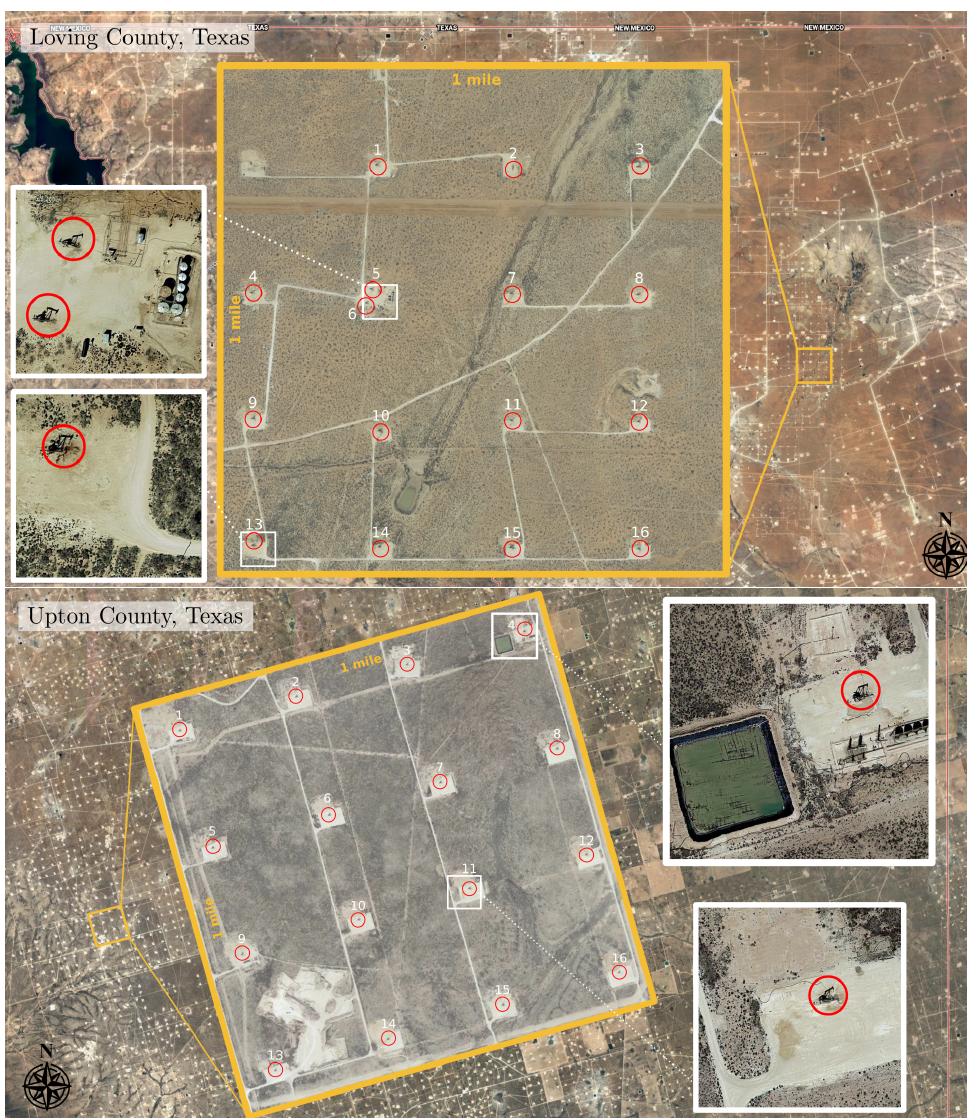
Figure 11. Snapshots from Google Earth in Loving County, Texas (Delaware Basin) and Upton County, Texas (Midland Basin). The densest area contains about 16 wells per square